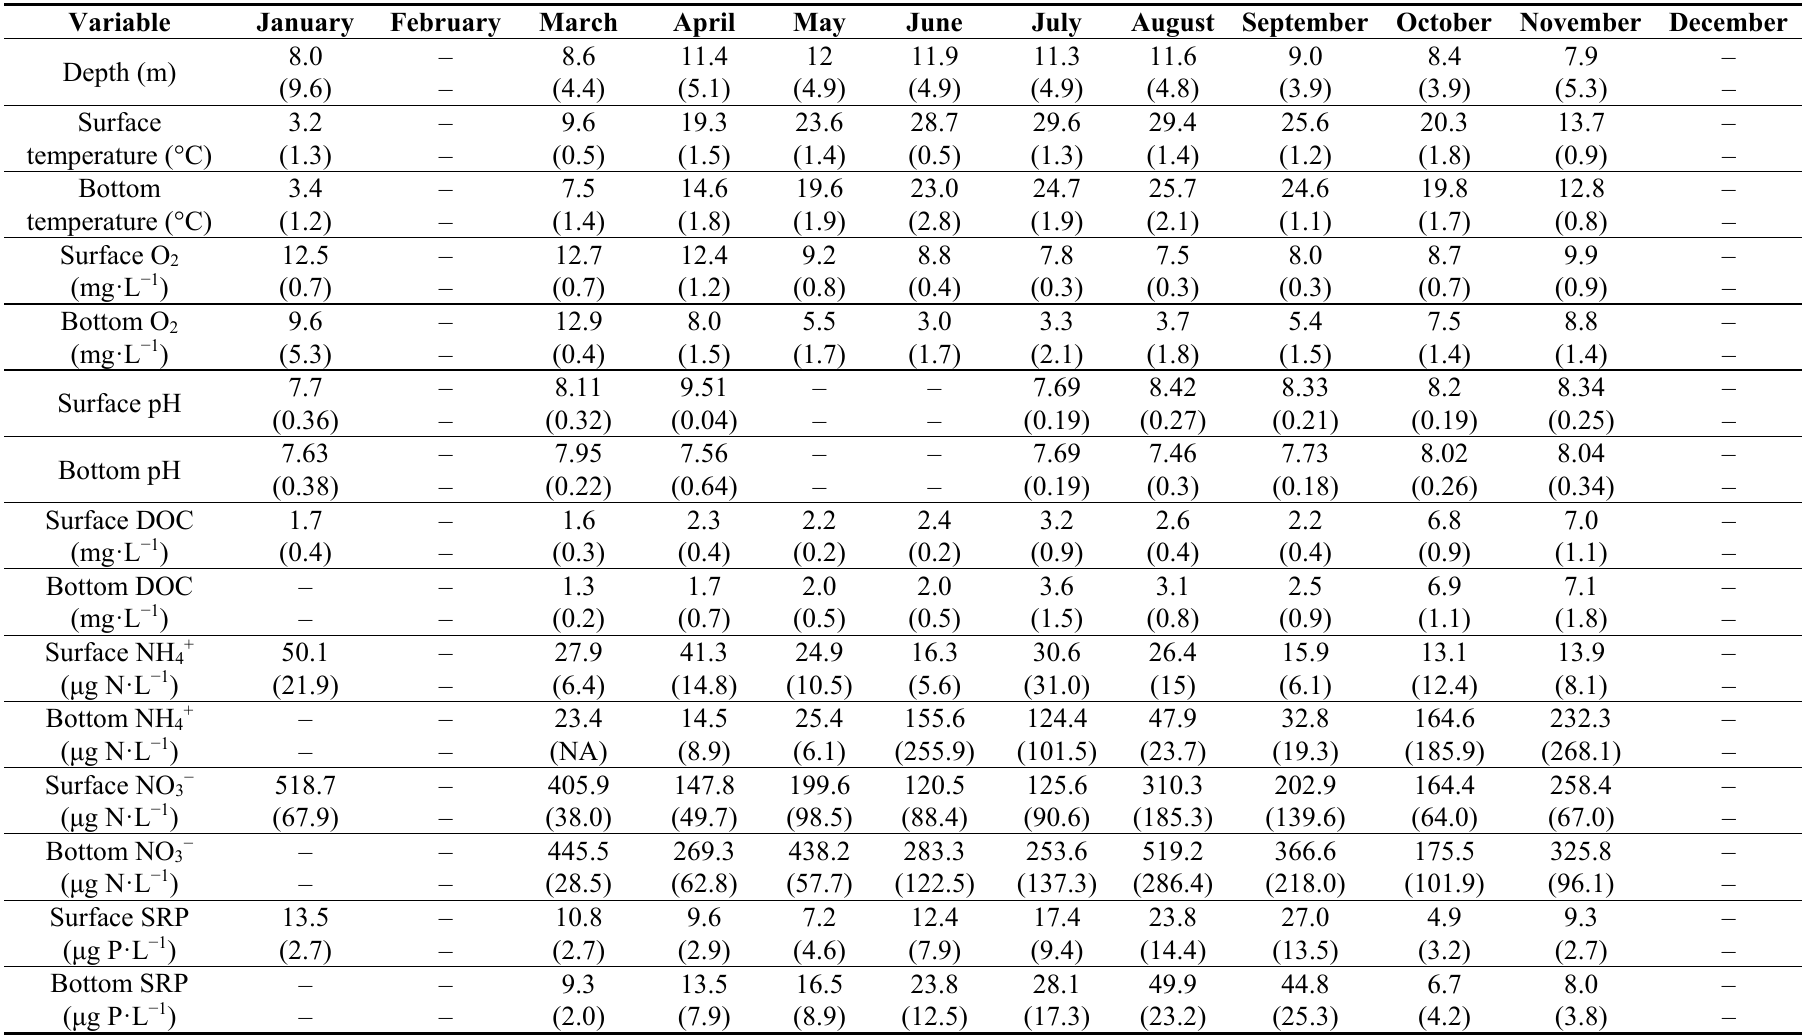
Table 3. Seasonal variation in physicochemical variables of Douglas Lake. Values are sample averages with 95% confidence intervals in parentheses. Confidence intervals for sample averages represented by a single sample ( i.e. , no spatial replication) are denoted with